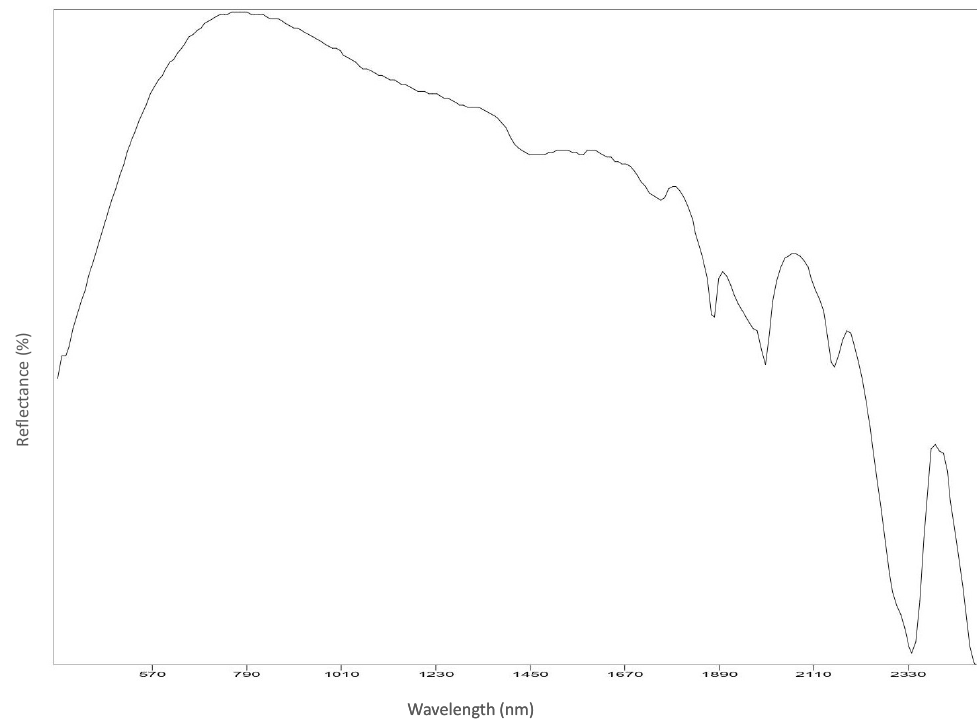
Figure A12. Left chest.